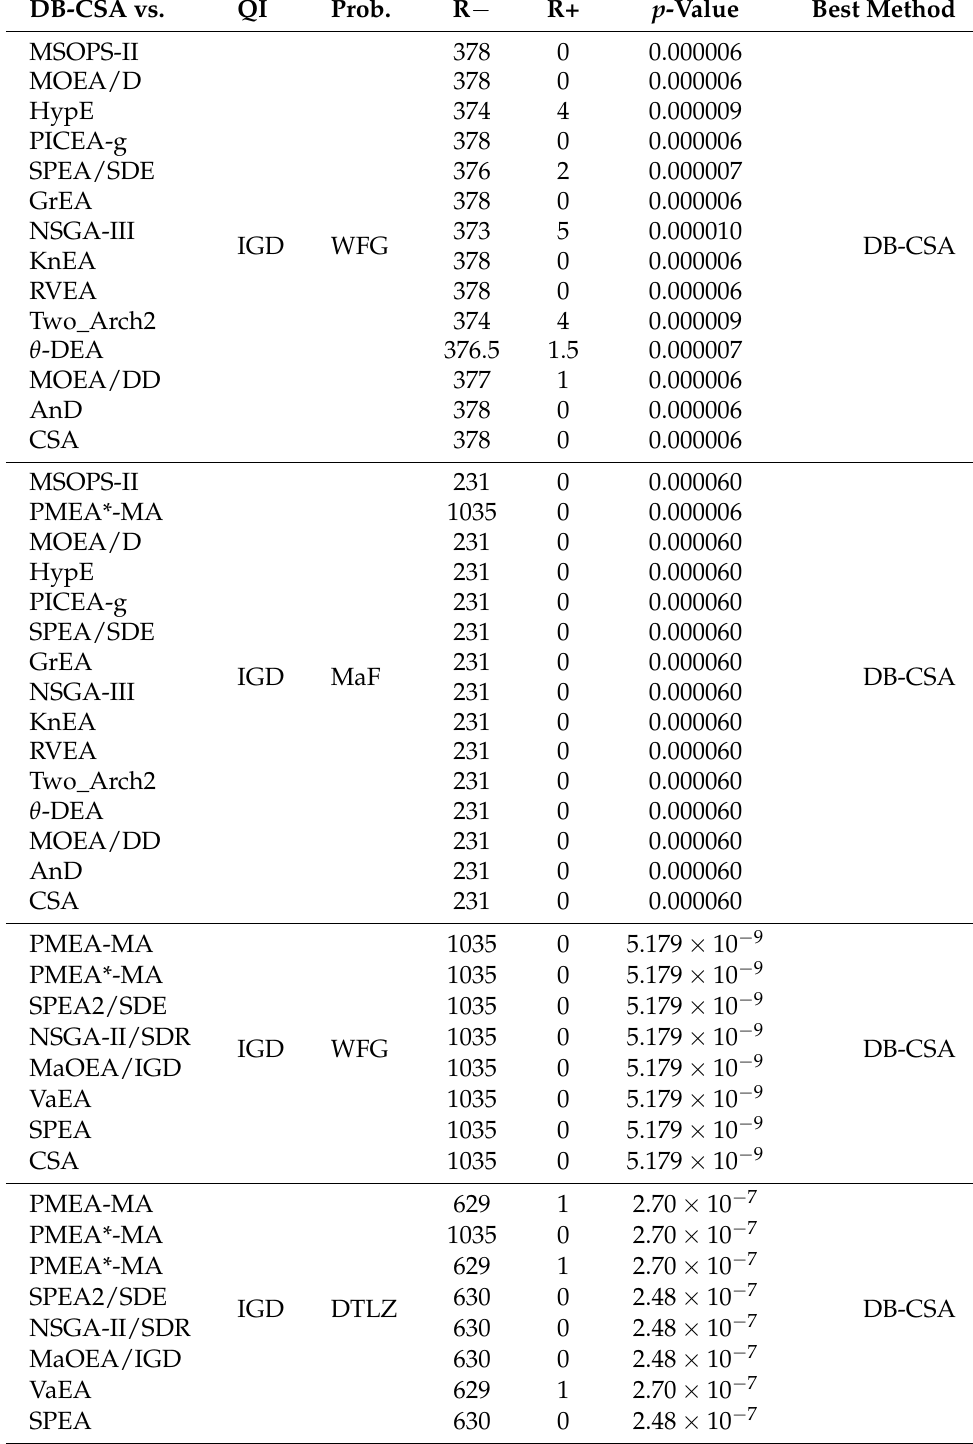
Table 10. Non-parametric statistical analysis based on Wilcoxon signed rank test of DB-CSA vs. thirteen peer MAOEAs over the IGD metric for WFG, MaF and DTLZ functions. DB-CSA